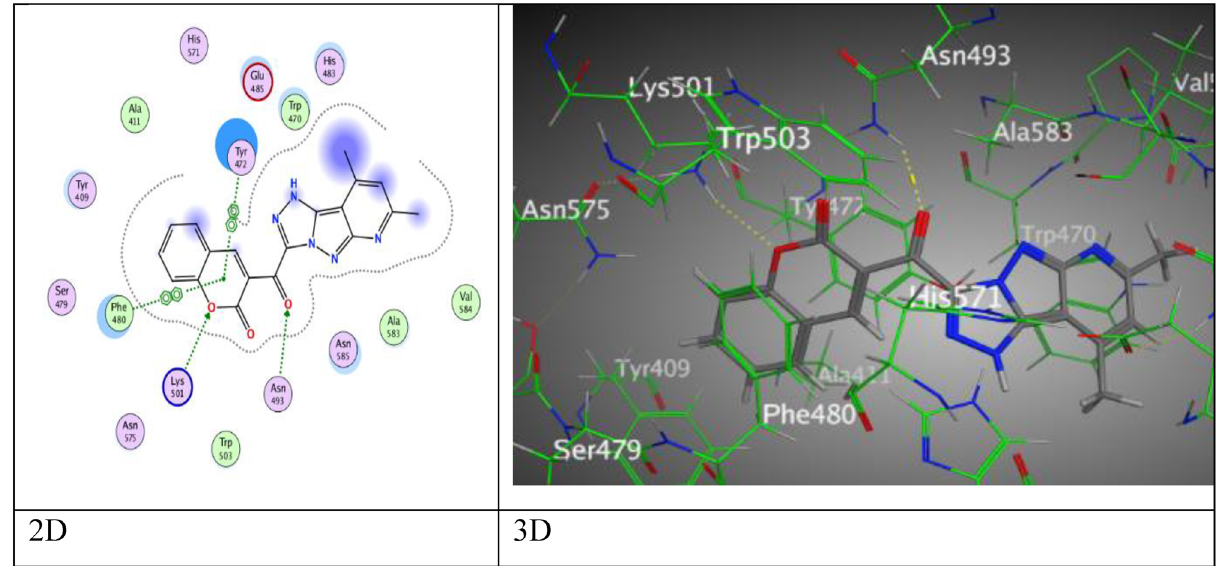
Figure 13. The binding interactions of compound 11 with active sites of (PDB ID: